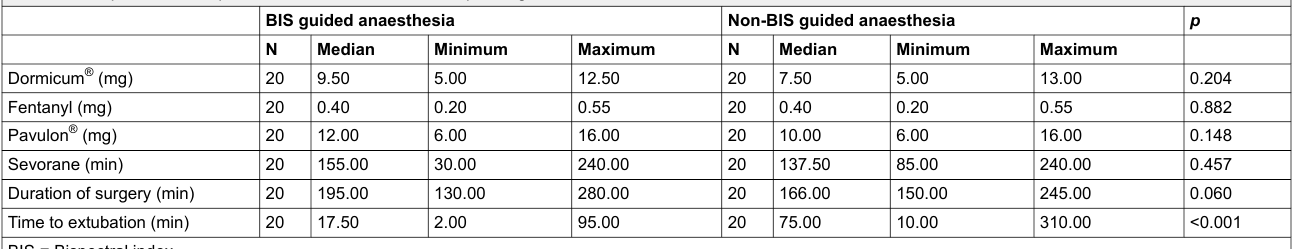
Table 2: Comparisons of required amounts of anaesthetics, operating time and time to